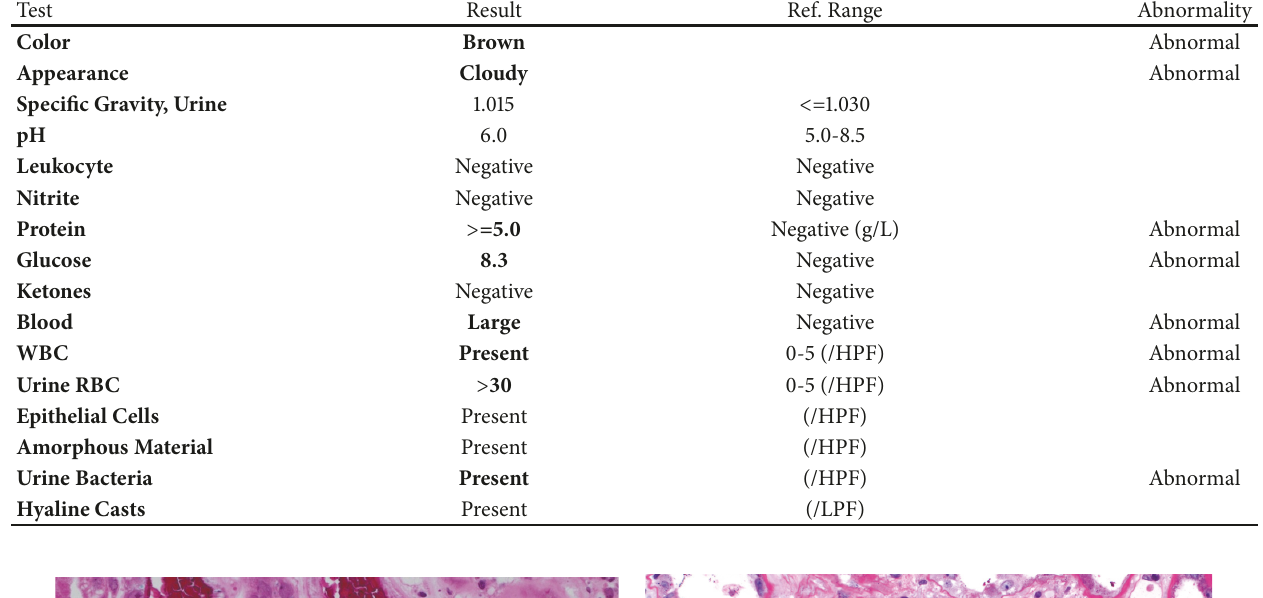
Table 1: Urine analysis.